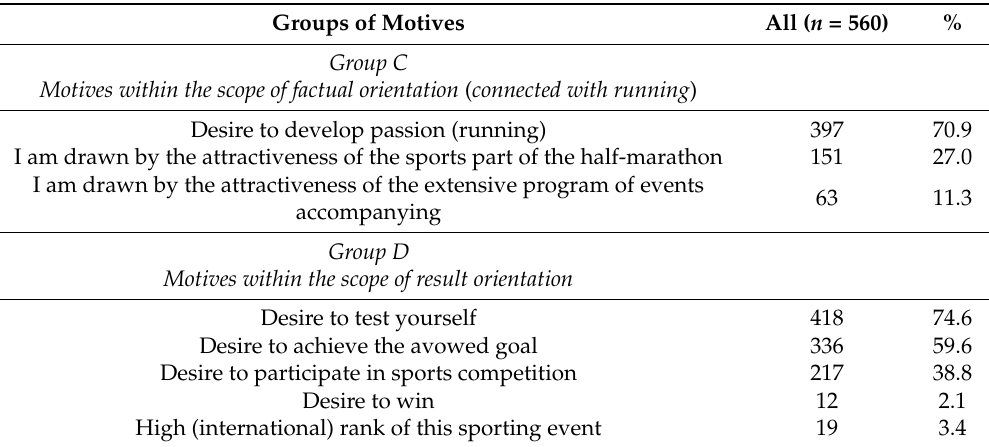
Table 3. Motives within the scope of factual and result orientation ( n = 560).